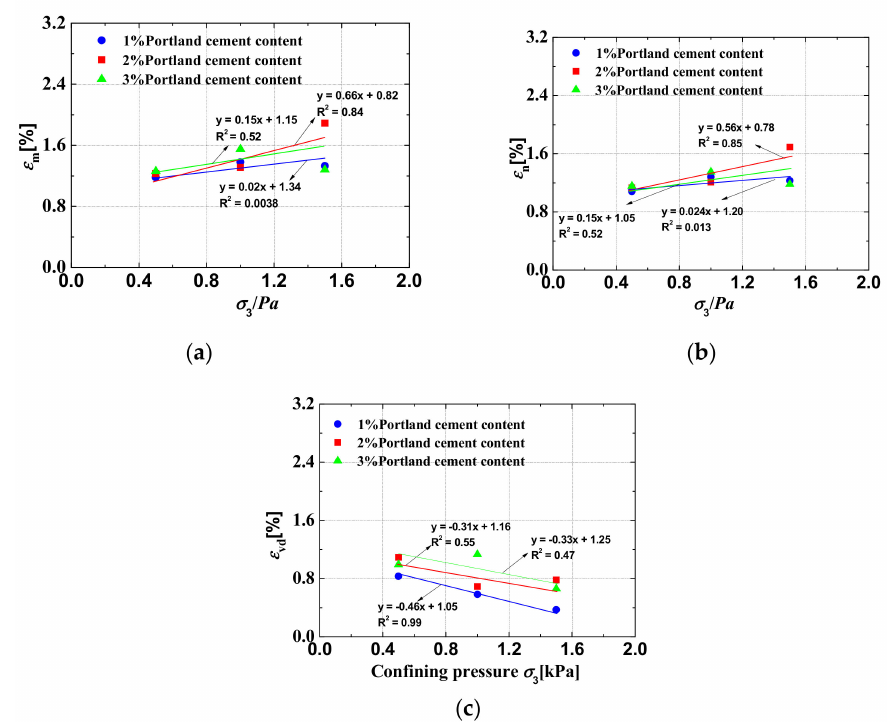
Figure 17. The verification of the expressions for the deformation characteristics of the cemented poorly graded sand–gravel mixture under di ff erent cement contents: ( a ) the relationship between the failure strain ε m and confining pressure σ 3 ; ( b ) the relationship between the axial strain of the peak point ε n and confining pressure σ 3 ; ( c ) the relationship between the peak volumetric strain ε vd and confining pressure σ 3